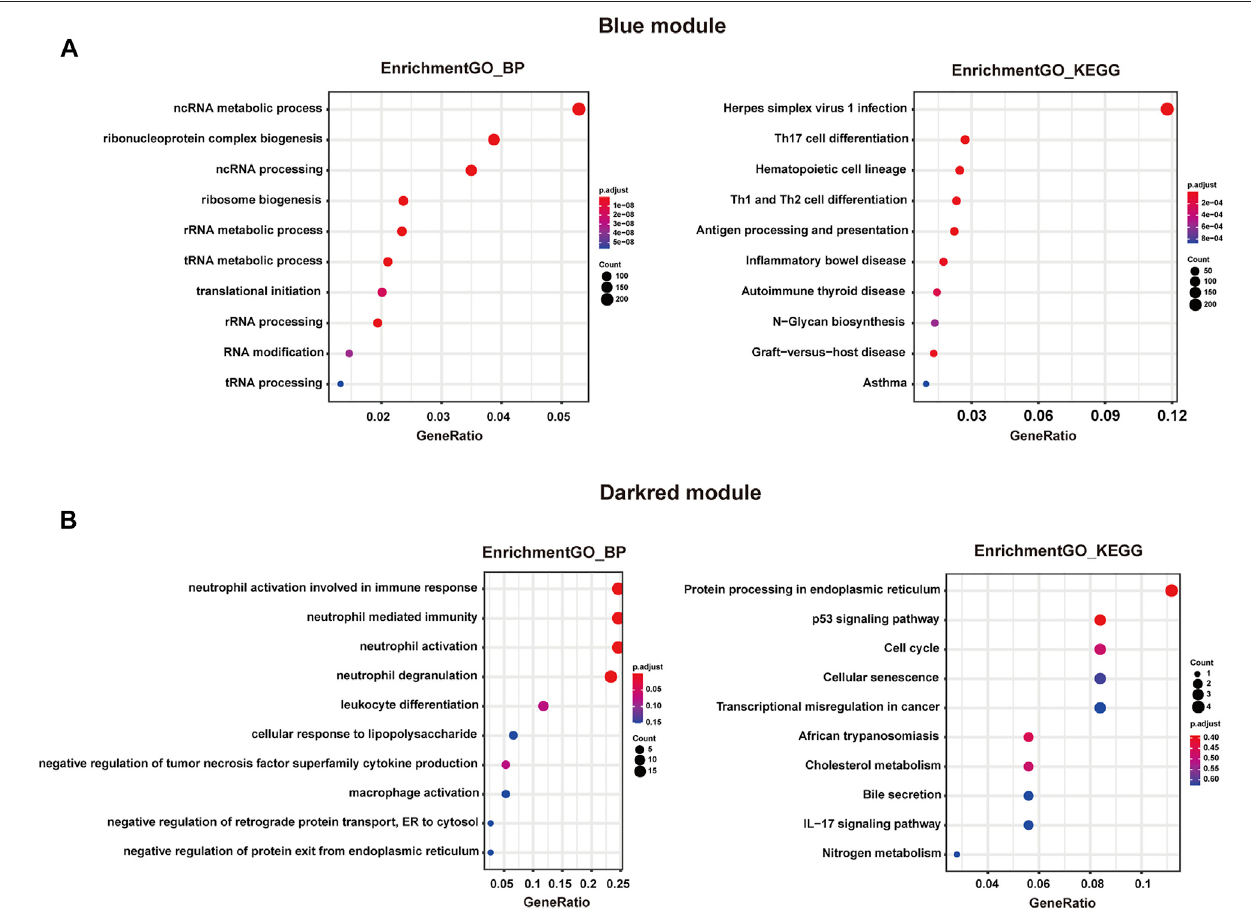
FIGURE3 | Functional enrichmentanalysis ofgenes in theblue and darkred modules. (A) Leftpanel: GOanalysisshowed top tenenriched biologicalprocesses in bluemodule.Rightpanel:KEGGanalysisshowedtoptenenrichedpathwaysinbluemodule. (B) Leftpanel:GOanalysisshowedtoptenenrichedbiologicalprocessesin darkred module. Right panel: KEGG analysis showed top ten enriched pathways in darkred